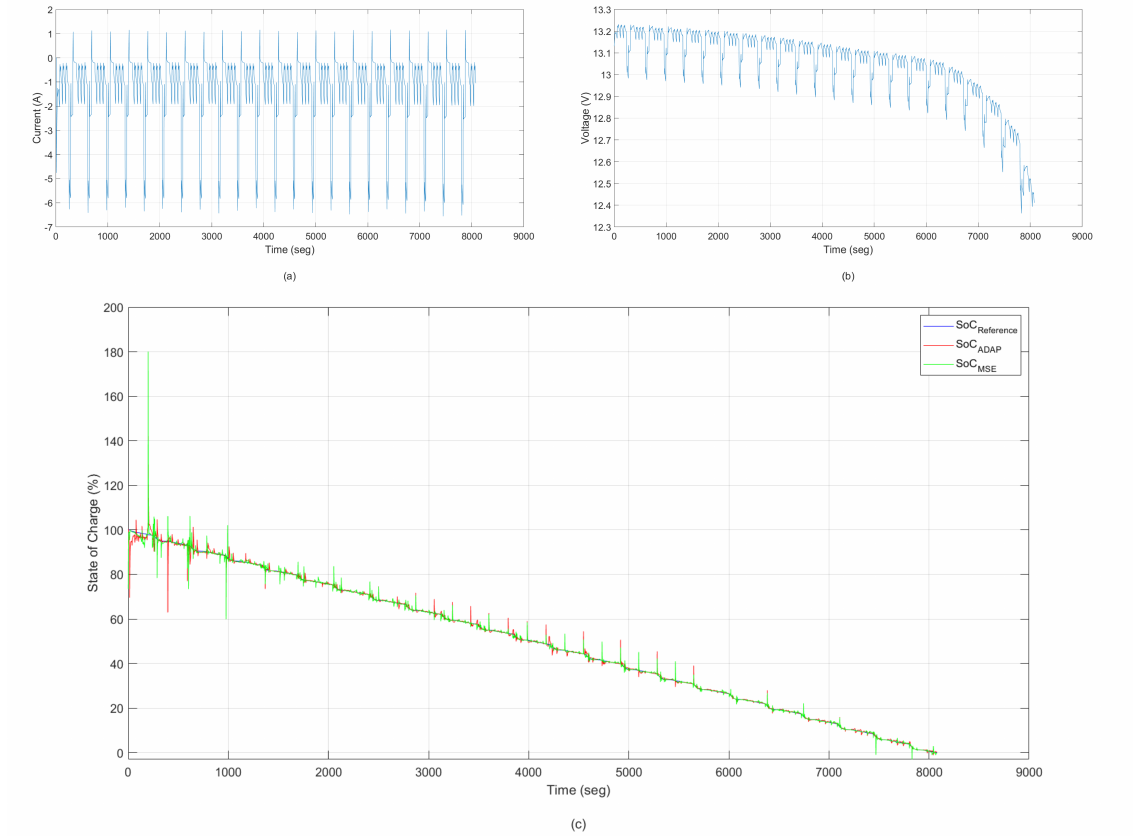
Figure 12. Validation of ANN models. State of Charge—training result without the presence of noise and outliers—Dynamic Stress Test: ( a ) current; ( b ) voltage for the DST cycle and ( c ) state of charge (SoC)